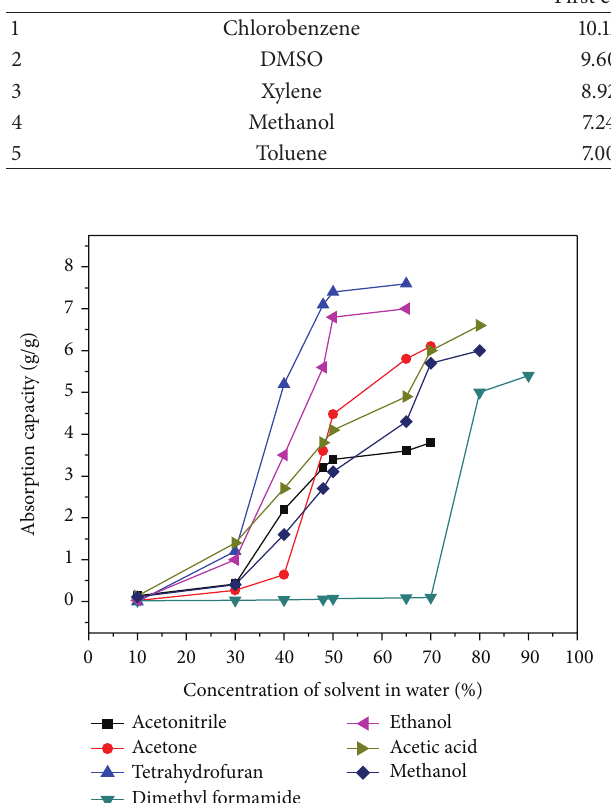
Figure 9: Capacities of silica aerogel adsorbing solvents from their aqueous solution.